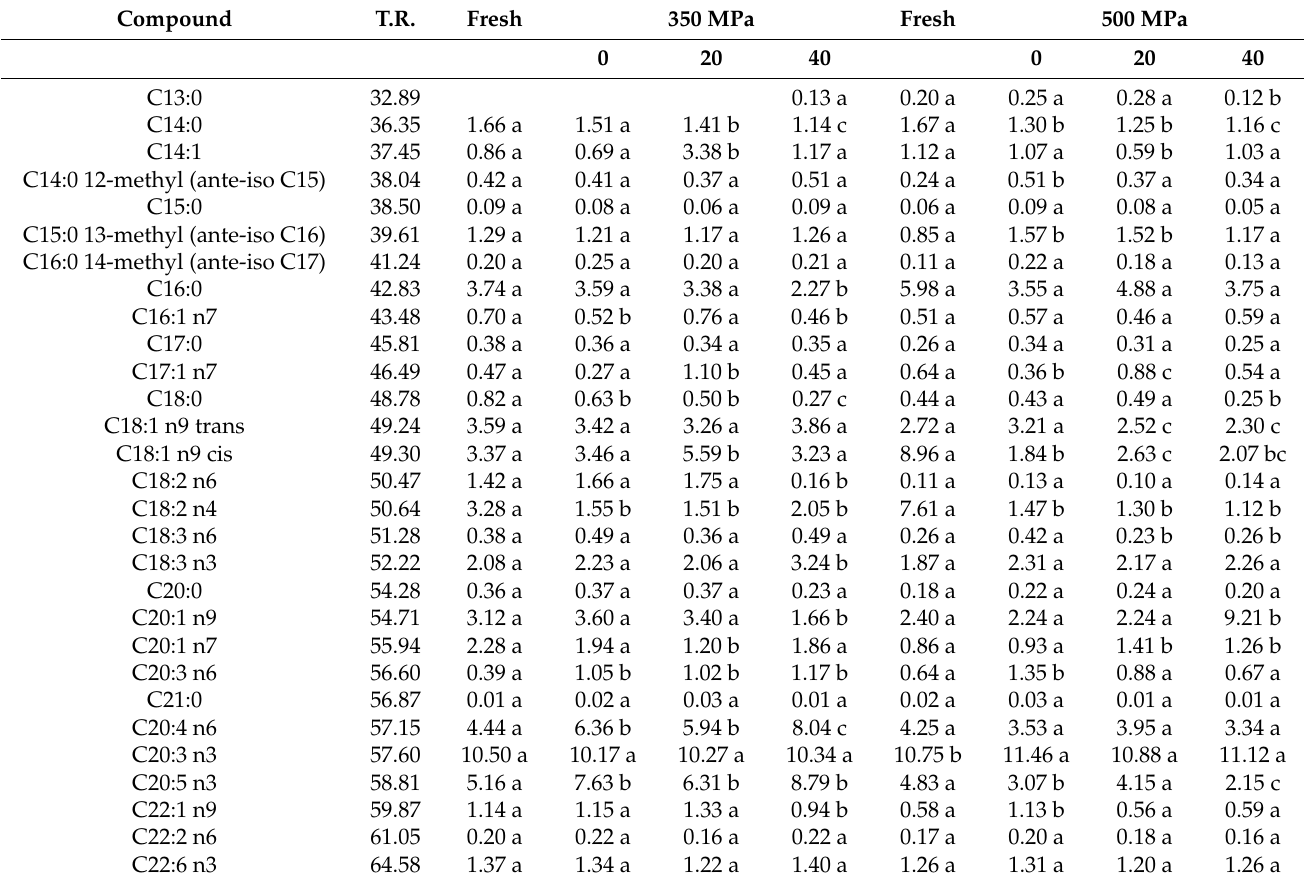
Table 7. Fatty-acid composition (g/100 g) of fresh and processed gonads of P. lividus